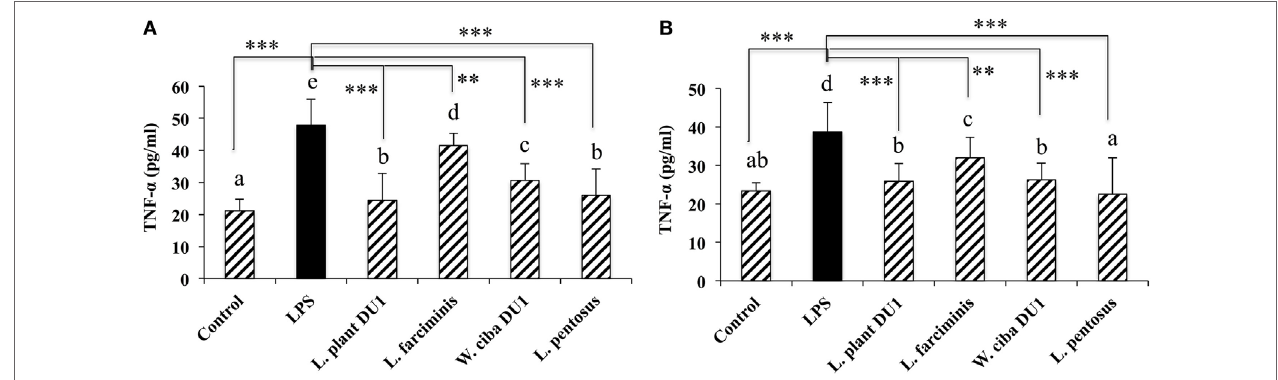
FigUre 3 | Lactic acid bacteria (LAB) strains reduce TNF- α production by THP-1 cells (a) and HepG2 cells (B) . In the co-culture setup, the apical side that contain HepG2 cells were stimulated with heat-killed LABs for 48 h, after which THP-1 cells taken in the basolateral side was treated with LPS for 12 h. The release of TNF- α in the both apical and basolateral compartment was determined by enzyme linked immunosorbent assay. Cells treated with either medium or LPS alone were used as controls. The results presented as an average values (mean ± SD) of three independent experiments. Different superscript letters indicate significant differences at the 0.05 level. Stars (** and ***) indicate significant differences at p < 0.005 and p < 0.0001 respectively.